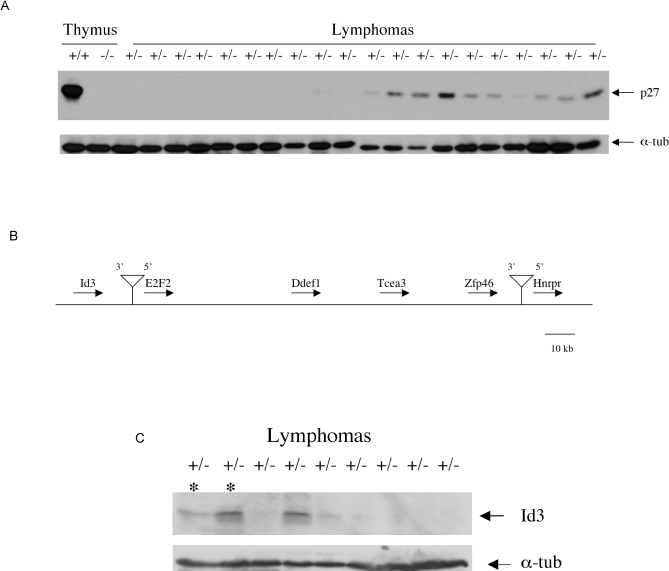
Analysis of M-MuLV Induced Lymphomas from p27
+/− Mice(A) Western analysis of p27 protein levels in p27 wild-type and p27
−/− thymus tissues and 20 of the 44 p27
+/− lymphomas. The blots were probed with α-tubulin as a loading control.(B) A schematic of the region on Chromosome 4 flanking the retroviral insertion sites is shown. The relative positions of Id3, E2F2, Ddefl1, Tcea3, Zfp46, and Hnrpr are indicated.(C) Id3 protein levels in a subset of the lymphomas from (A) p27
+/− lymphomas. α-tubulin is shown as a loading control. The tumors with Id3 retroviral insertions near Id3 are indicated with an asterisk. The lymphoma with M-MuLv insertion closest to Id3 has the highest level of Id3 protein.doi:10.1371/journal.pgen.0030219.g001